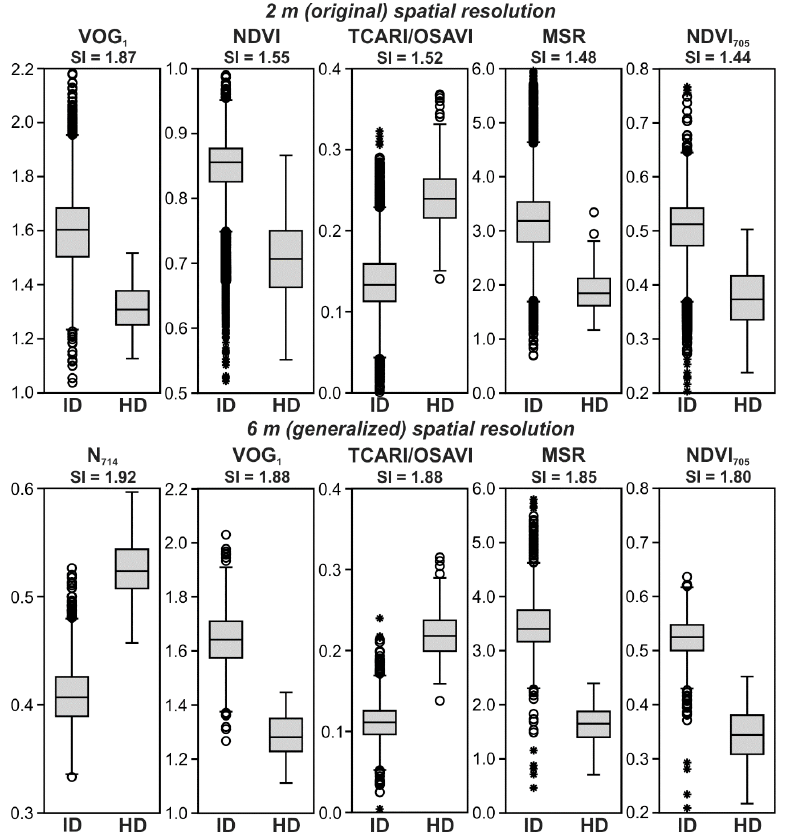
Figure 5. Values of the most sensitive vegetation indices calculated from original (2 m) and generalized (6 m) spatial resolution ASAS imagery from 1998. ID stands for initially damaged stands (in total 14 sites), whereas HD stands for moderately to heavily damaged forest stands (in total two sites). SI represents separability scores.